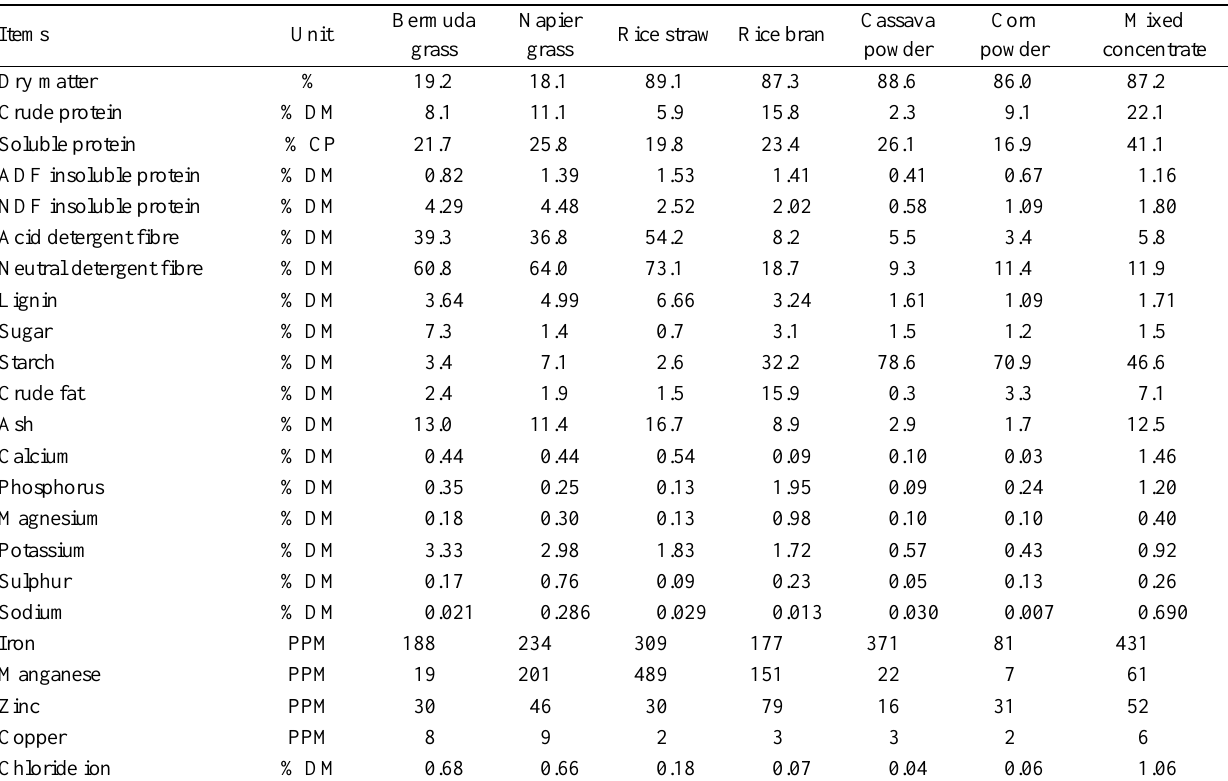
Table 2. Feed quality values for selected samples from the five studies used to evaluate the large ruminant nutrition system model Items Unit